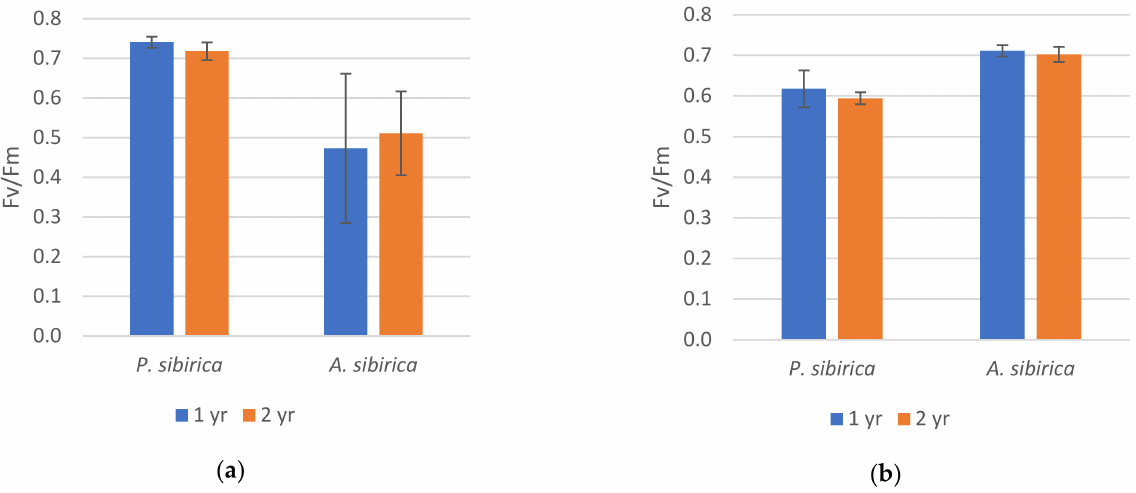
Figure 3. The maximum quantum yield of the PSII (Fv/Fm) in P. sibirica and A. sibirica needles at the highest point ( a ) and the lowest point ( b ) of the study transect. The vertical bars represent the standard deviation. At each sample point, three measurements of one– and two–year–old needles were taken for both P. sibirica and A. sibirica .